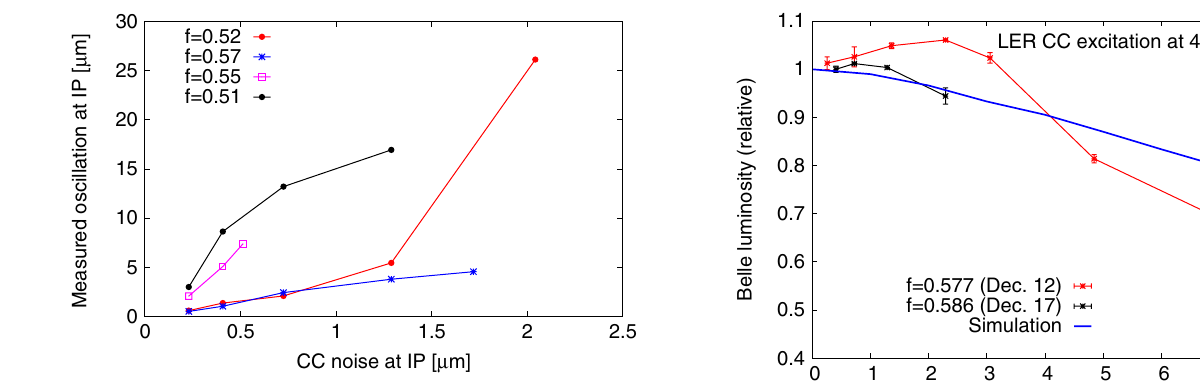
FIG. 13. Observed coherent oscillations versus amplitude of the CC harmonic excitation. Both quantities expressed as equivalents at the IP location. The nominal IP horizontal beam size is 160 (cid:3) m